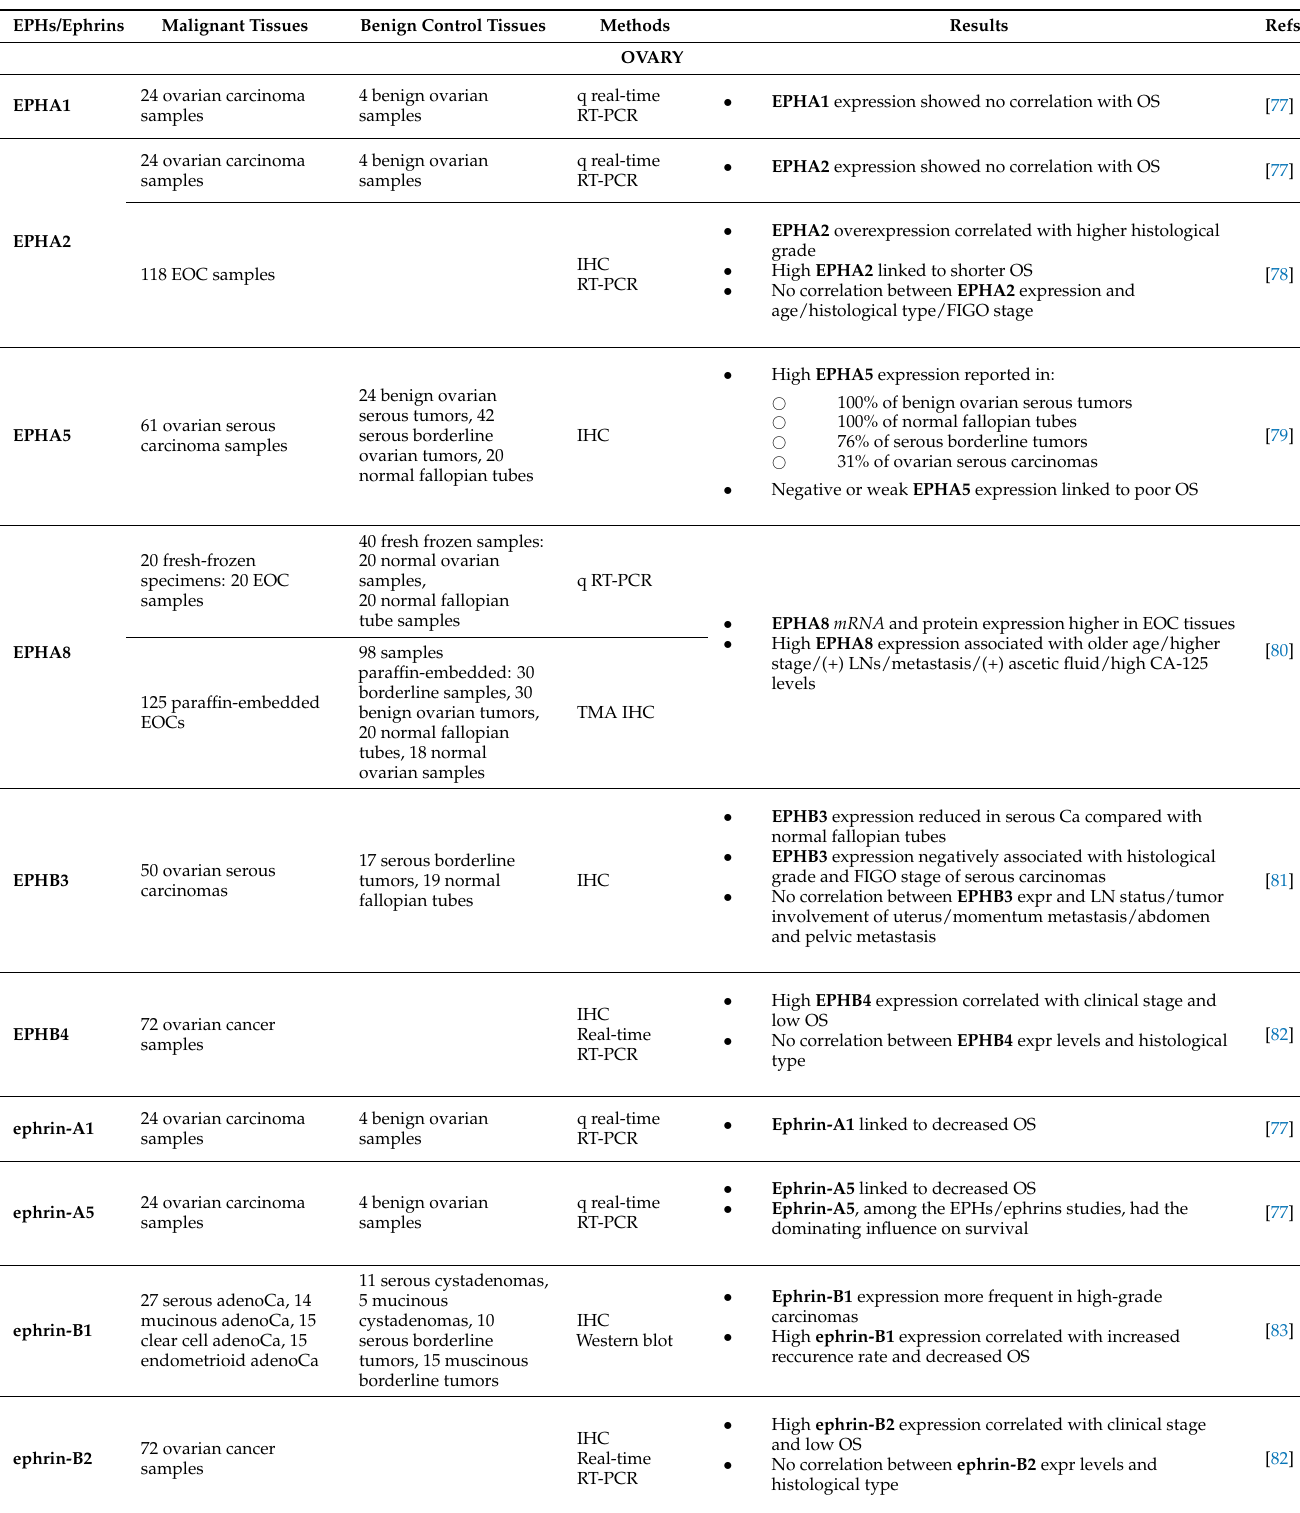
Table 5. EPHs/ephrins (bold) studied in solid tumors of the gynecological tract and correlations with clinicopathologi- cal